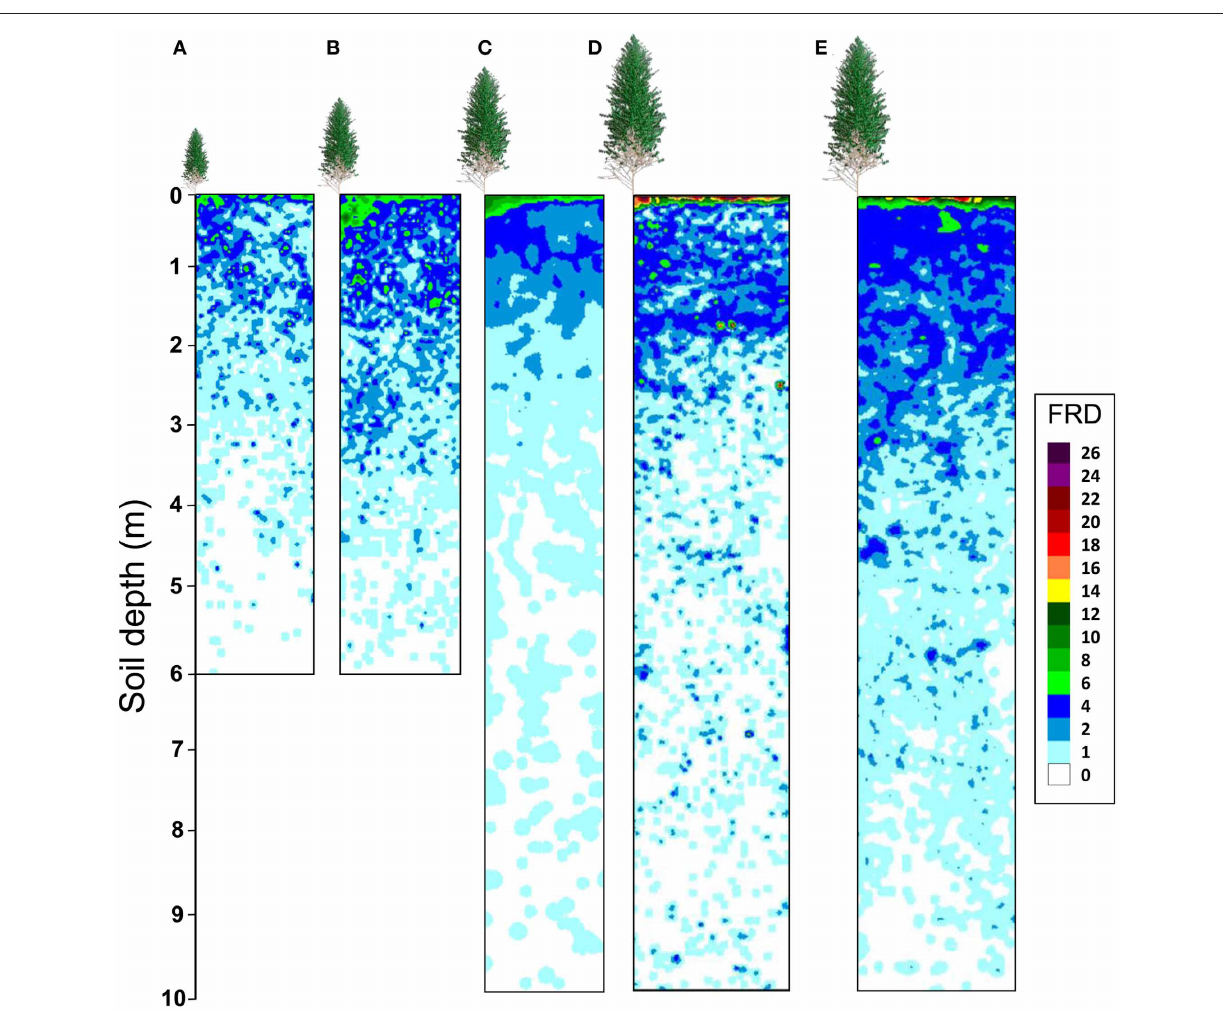
to a depth of 10m in 3.5-year old (C) and 6-year-old (D) stands on a sandy soil (20% clay). Fine root densities down to a depth of 10m in a 6-year-old stand on a clayey soil were also studied (E) . Eucalypts indicate the position of the nearest tree (not at the scale of soil